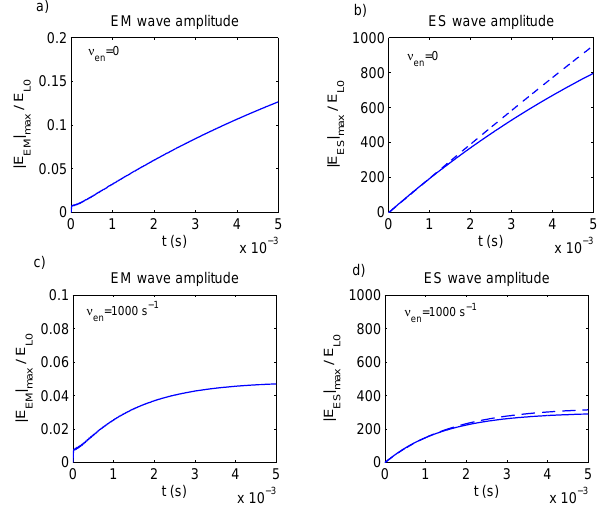
Figure 3. Close-ups of the density profiles associated with density striations for 1, 7 and 19 striations (panels (a) – (c) ) organized in a hexagonal pattern in the x – y plane. The central distance between nearest neighbor striations is 24.53m.